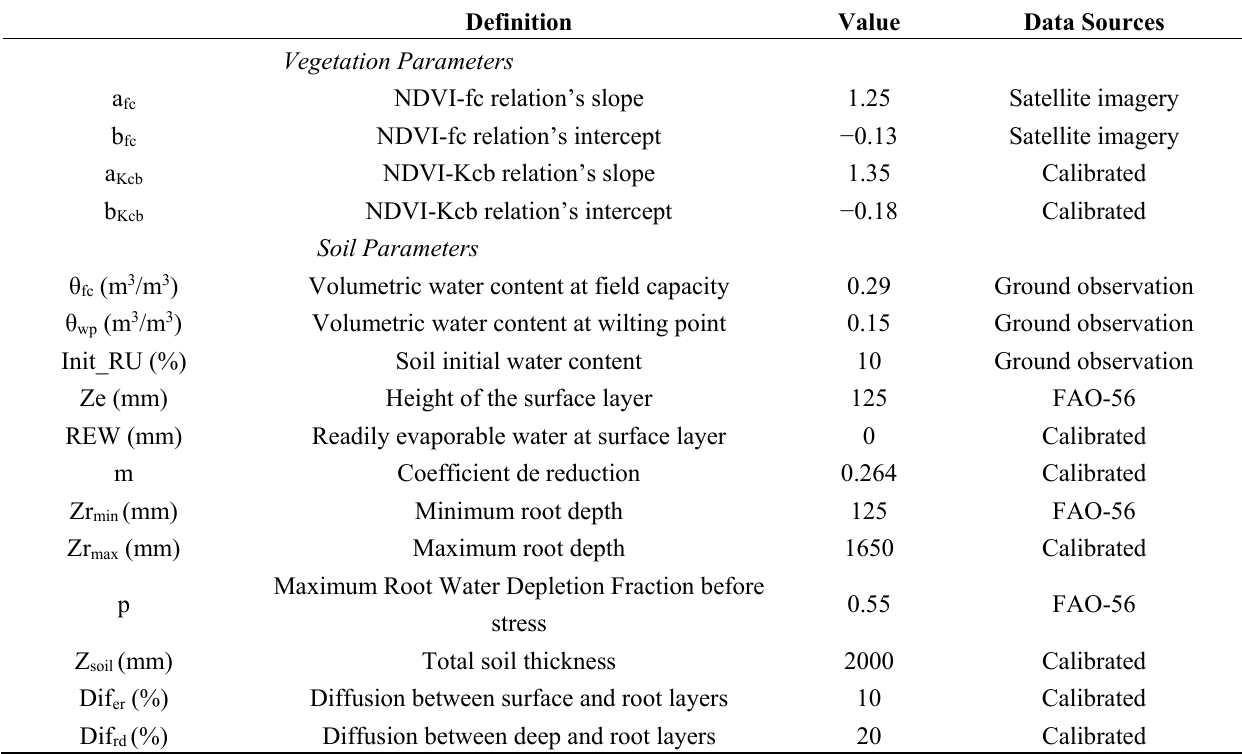
Table 1. Parameters obtained after calibration on observed ET for wheat and barley plots. Grey cells show calibrated parameters.